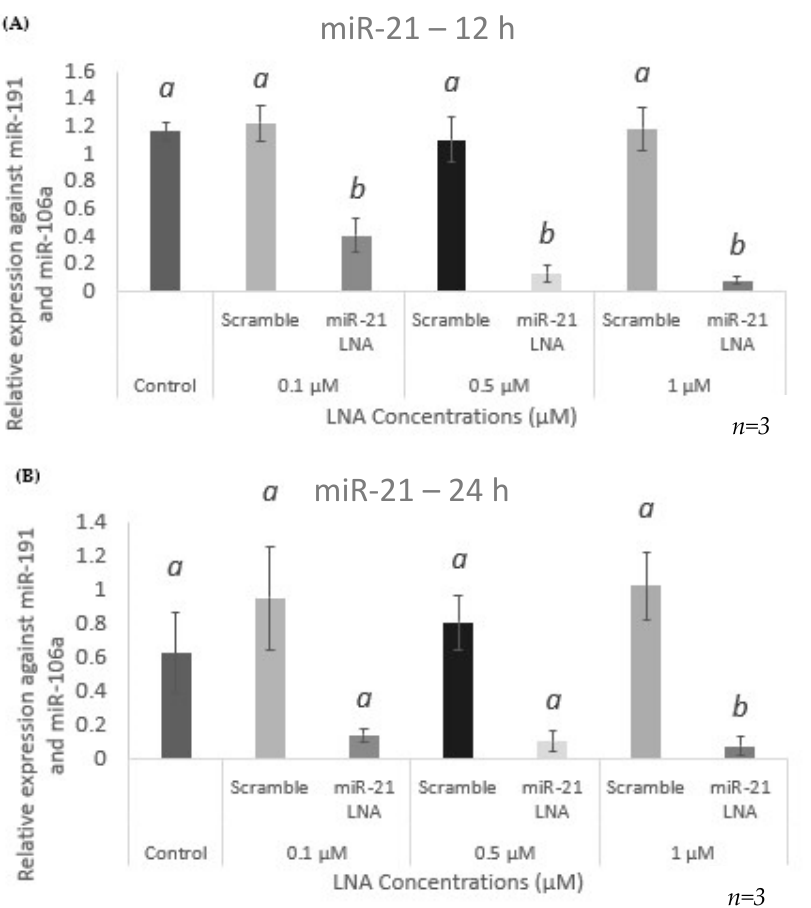
Figure 4. mi-21 expression at different LNA concentrations . miR-21 was significantly decreased in all three concentrations tested at 12 h but the difference was only significant for 1 µ M at 24 h. Transfections with LNA probes at 0.1 µ M, 0.5 µ M, and 1 µ M for 12 h ( A ) and 24 h ( B ). Quantification is relative to reference targets miR-191 and miR-106a. Different letters indicate significant differences, with b indicating a significantly different mean than a at p < 0.001. Bars represent the mean ± SEM. 2.4. Specificity of miR-21 LNAs Shown through No Effects on Other miRNAs except for